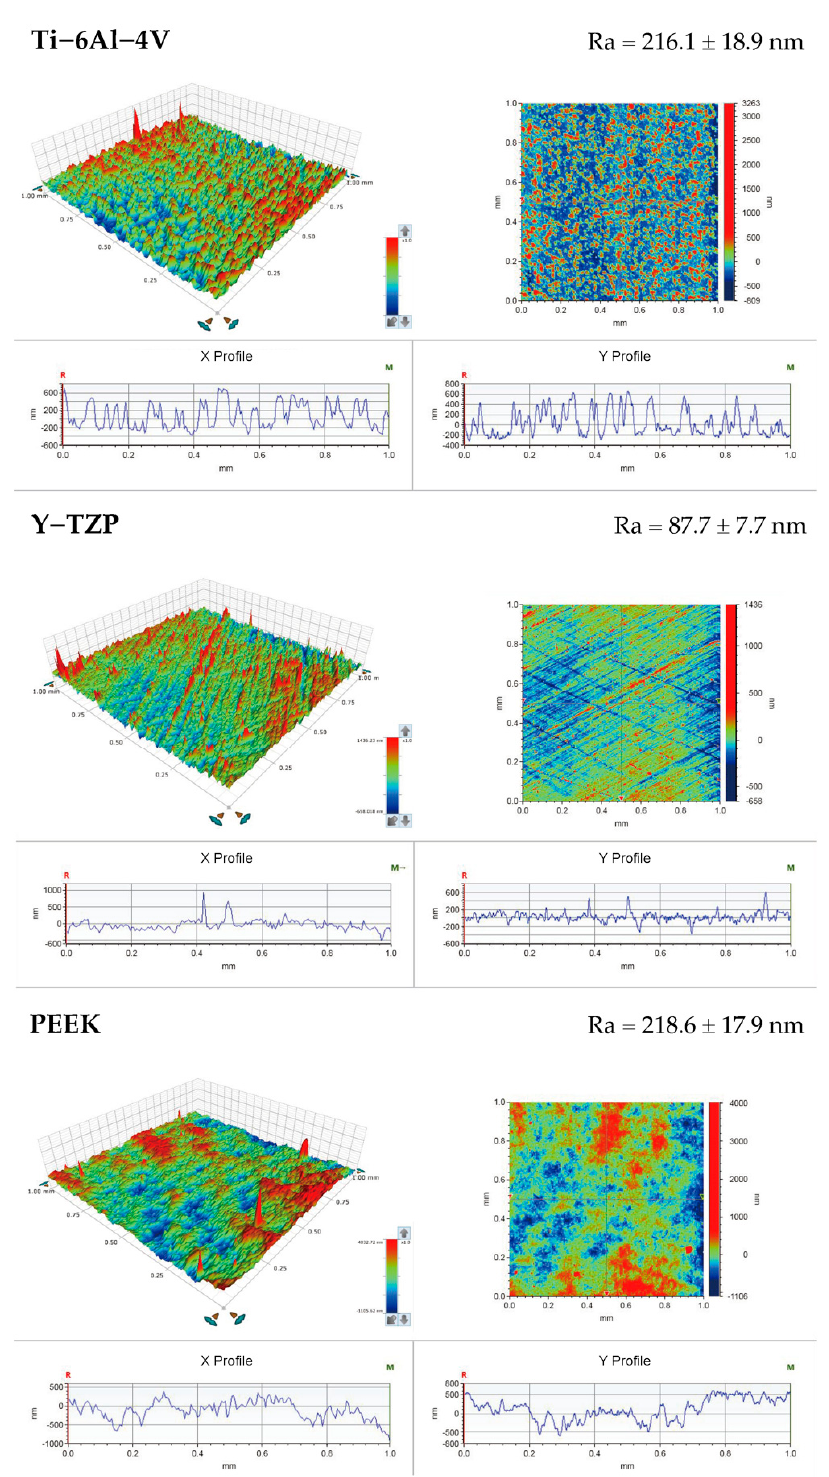
Figure 3. Surface roughness results of each dental materials.